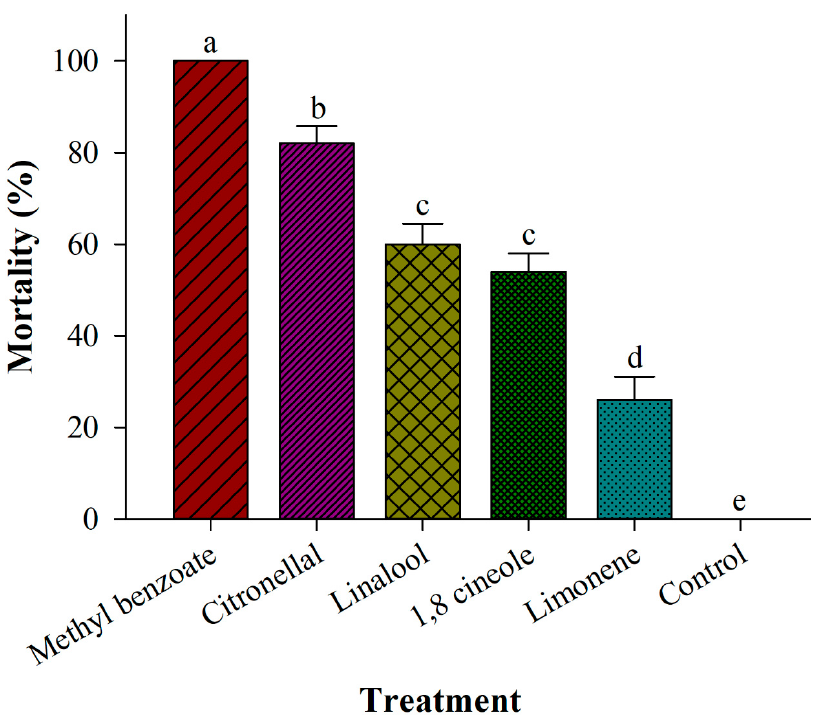
Figure 5. Effects of tested monoterpenes on the mortality of Plodia interpunctella adults after 4 h of exposure. Different lowercase letters above bars represent significant differences at p < 0.05.